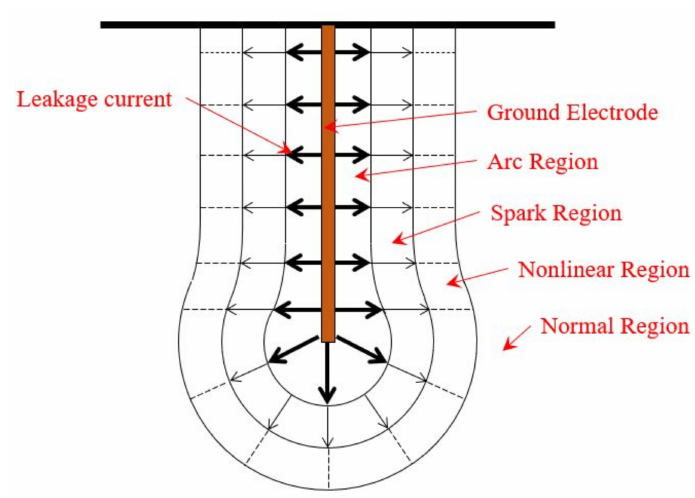
Figure 1. Soil breakdown region in a grounding electrode. The zones in the ground around the electrode that are known as the spark region, nonlinear region and normal region can be represented as the ionization zone, deionization zone and the non-ionization